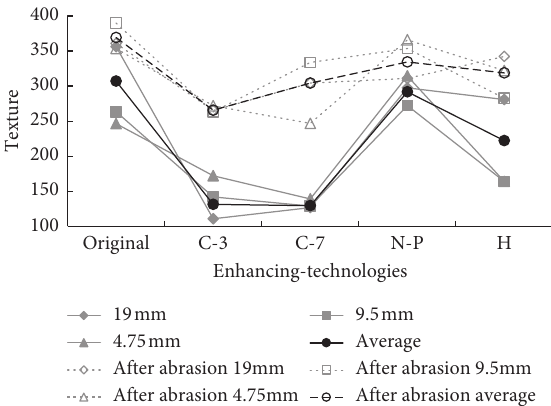
Figure 8: Angularity of RA before and after chemical enhancing-